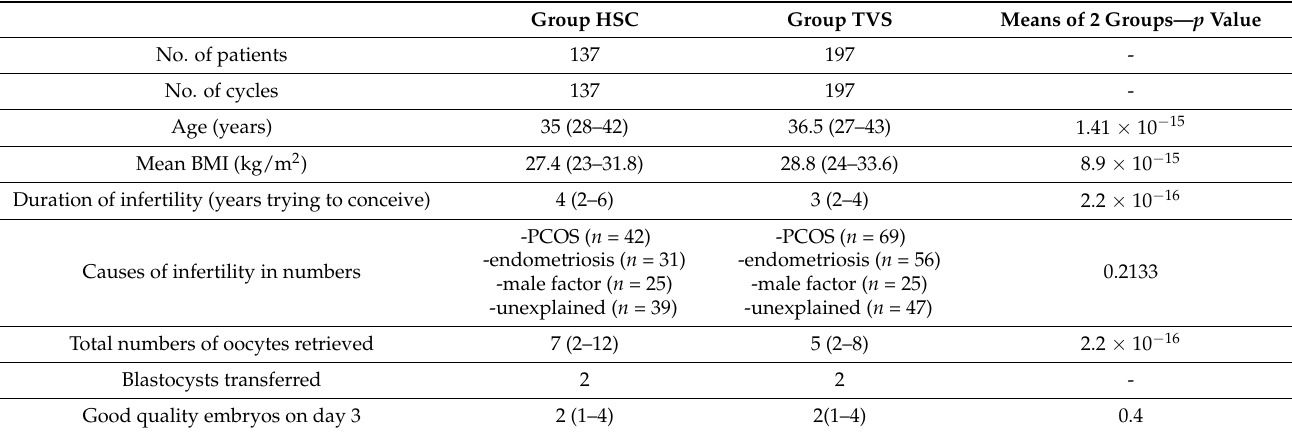
Table 1. Main Study